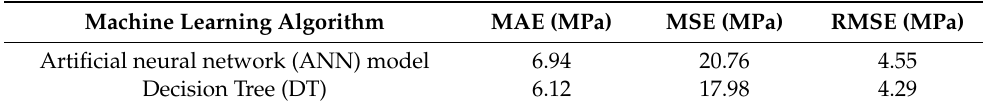
Figure 10. Statistical Indication for k-fold cross validation for the DT model. Table 7. Statistical